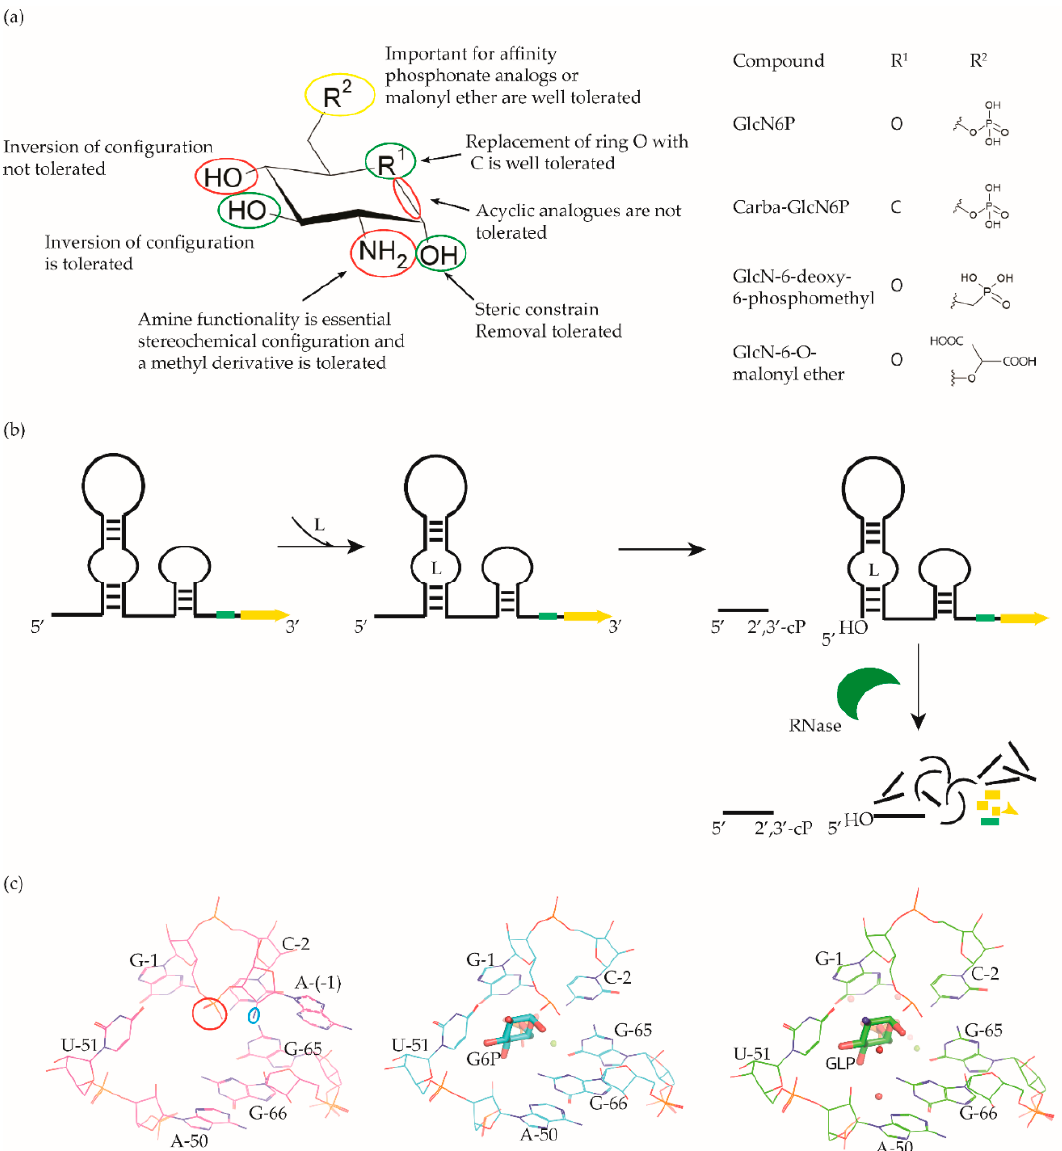
Figure 4. glmS riboswitch ligands. ( a ) Chemical structures and structure–activity relationships (SAR) of the GlcN6P derivatives. Positions where changes are well tolerated are marked in green, moderately tolerated in yellow and not tolerated in red. ( b ) Cartoon representation of ligand-dependent glmS ribozyme activity. The RBS is shown as a green bar and the ORF in yellow. Binding of ligand induces glmS riboswitch self-cleavage to produce an upstream fragment with a 2 ′ ,3 ′ - cyclic phosphate end (2 ′ ,3 ′ -cP) and a downstream fragment with a 5 ′ -OH end, followed by degradation of the latter by a specific RNase. ( c ) Snapshot of the binding pocket of the glmS riboswitch in the apo form (PDB ID: 2GCS, left), in complex with glucose-6-phosphate (PDB ID: 2Z74, center), and GlcN6P (PDB ID: 2Z75, right). The nucleophile that ends up in the upstream fragment (2 ′ -OH group of A(-1)) is highlighted with a blue circle and the leaving group (5 ′ -phosphate group of G1) with a red circle.